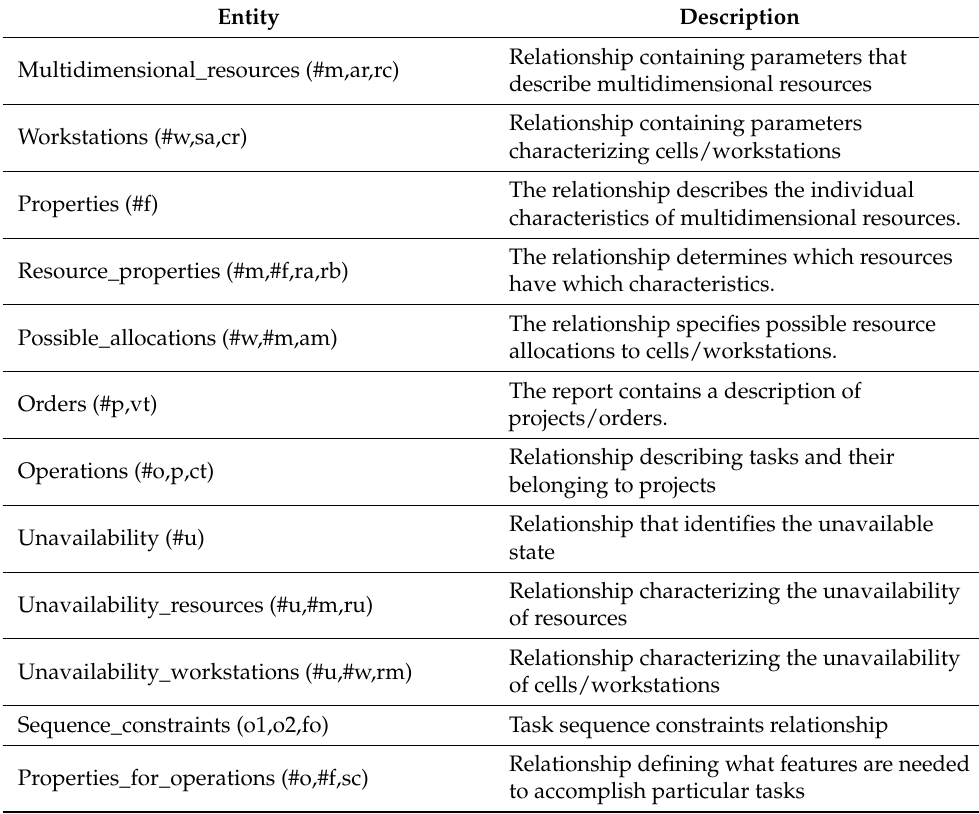
Figure 2. Entity Relationship Diagram (ERD) in Martin notation for the database of the problem under consideration. Table 5. Description of individual database entities.